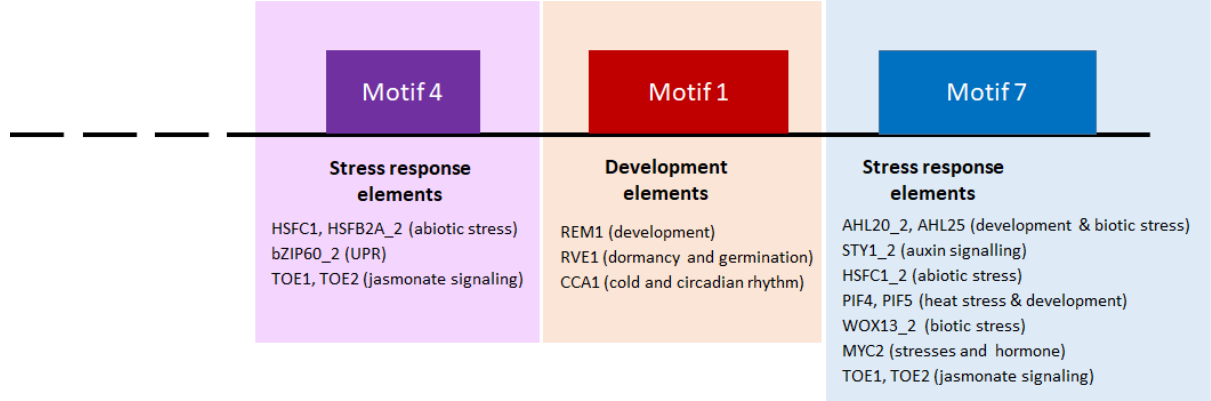
Figure 8. Schematic representation of the cis-elements belonging to the three identified conserved motifs among the 14 orthologous Triticeae GNAC genes. Only the 3′ terminal part of the promoter is represented (stopped at the beginning of the 5′ UTR). The motif 1 gathers cis-elements that may be involved in plant development. Motifs 4 and 7 present cis-elements that are involved in stress responses.